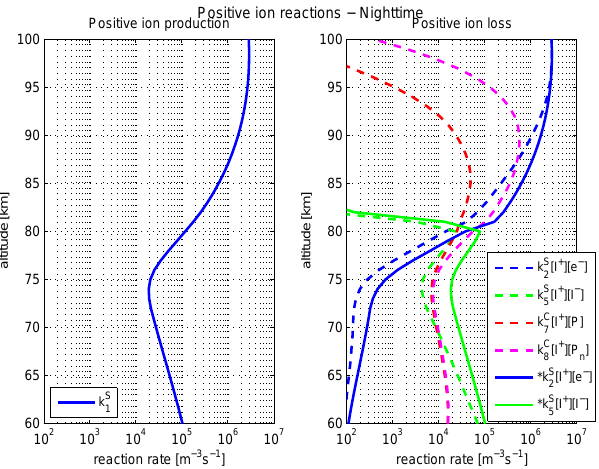
Fig. 12. As in Fig. 10, but for processes involving positive ions, see also Eq.